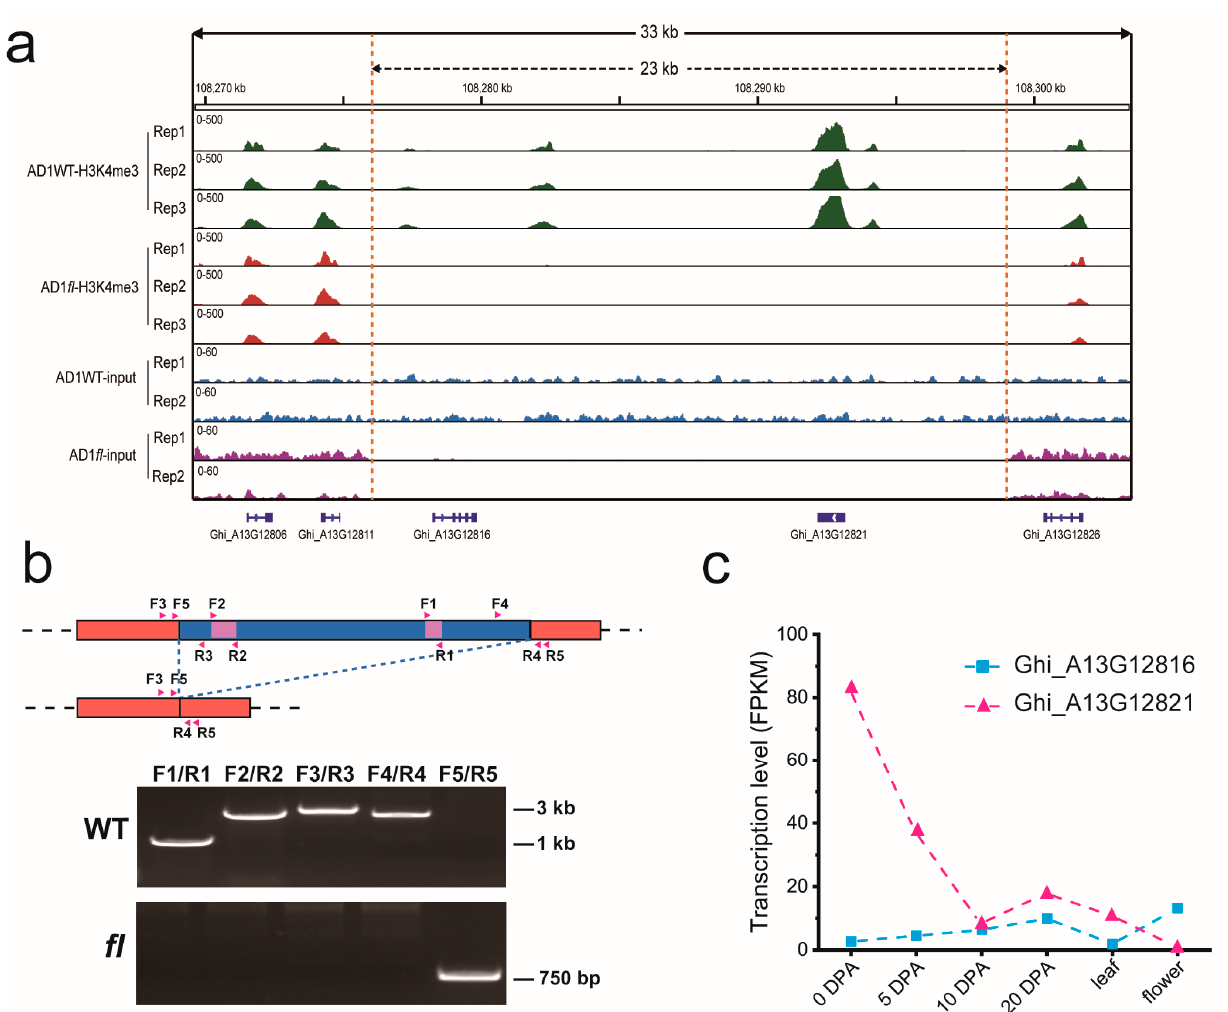
Figure 2. GhTZF2 presented a significant difference between WT and fl . ( a ) Genomic snapshot of the 23 kb deletion locus on chromosome A13, showing H3K4me3 ChIP-Seq signals (green for WT and red for fl , respectively), and input signals as reference (blue for WT and purple for fl ). The approximate 23 kb region between the orange dotted lines indicates the H3K4me3 signal discrepancy resulting from the genomic level between WT and fl . ( b ) Validation of 23 kb deletion on chromosome A13 via PCR amplification. The region between blue dotted lines indicates the 23 kb region discrepancy mentioned above. The two long red boxes indicate flanked regions in both WT and fl . F1~F5 and R1~R5 show the primer locus on the genomic level. ( c ) The transcription level (FPKM) of Ghi_A13G12816, Ghi_A13G12821 in WT, and fl. Data were collected from transcriptome data.